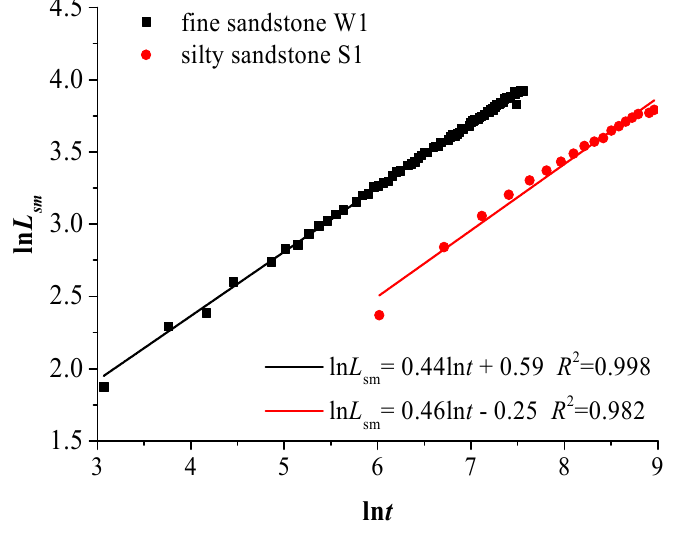
Figure 7. The double-logarithmic plots of L sm versus t for two kinds of specimens. Table 4. Sorptivity ( C m ) and goodness-of-fit (R 2 ) parameters of the fine sandstone (W1) and silty sandstone (S1).